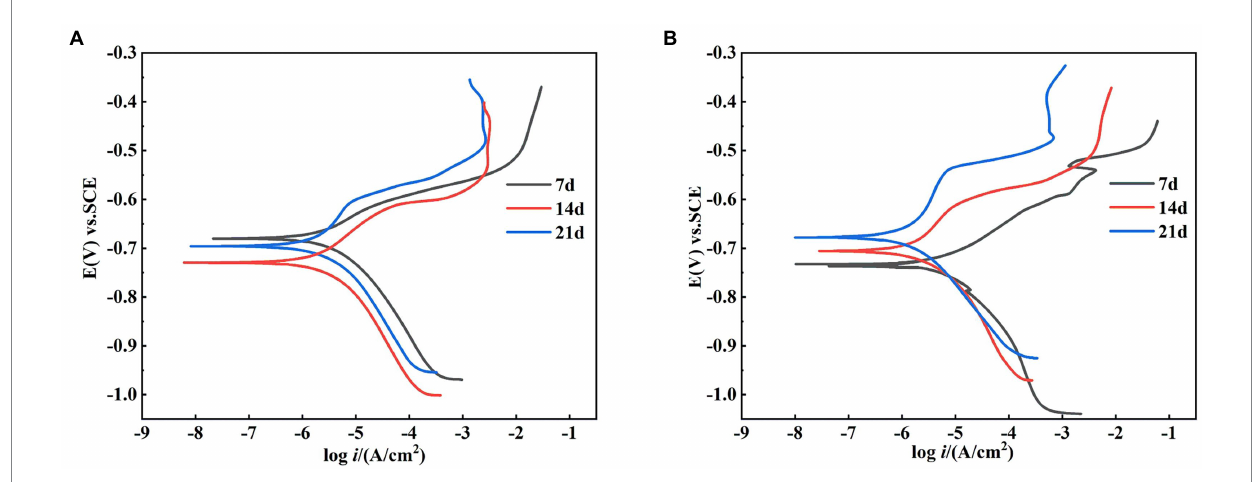
FIGURE 9 Kinetic potential polarization curves of X65 steel after 7, 14, and 21 d of polarization in (A) sterile and (B) Alcaligenes sp.